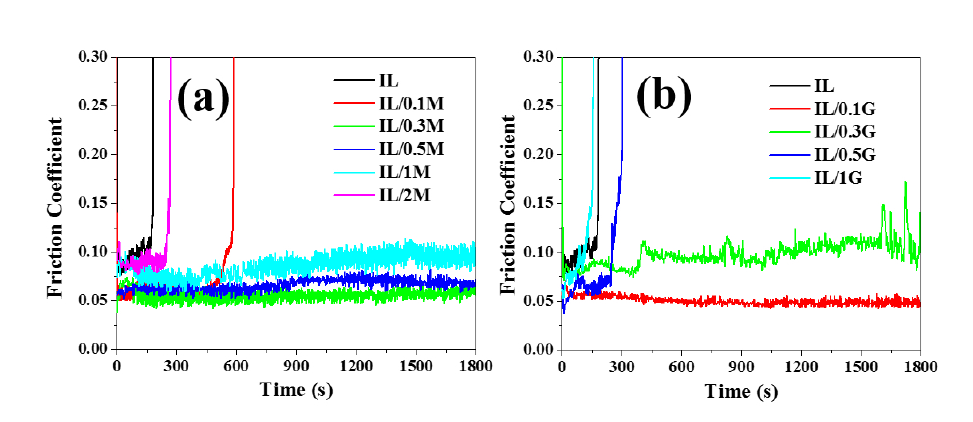
Figure 4. Friction coefficient as a function of sliding time for the IL films with different amounts of MoS 2 nanosheets ( a ) and graphene ( b